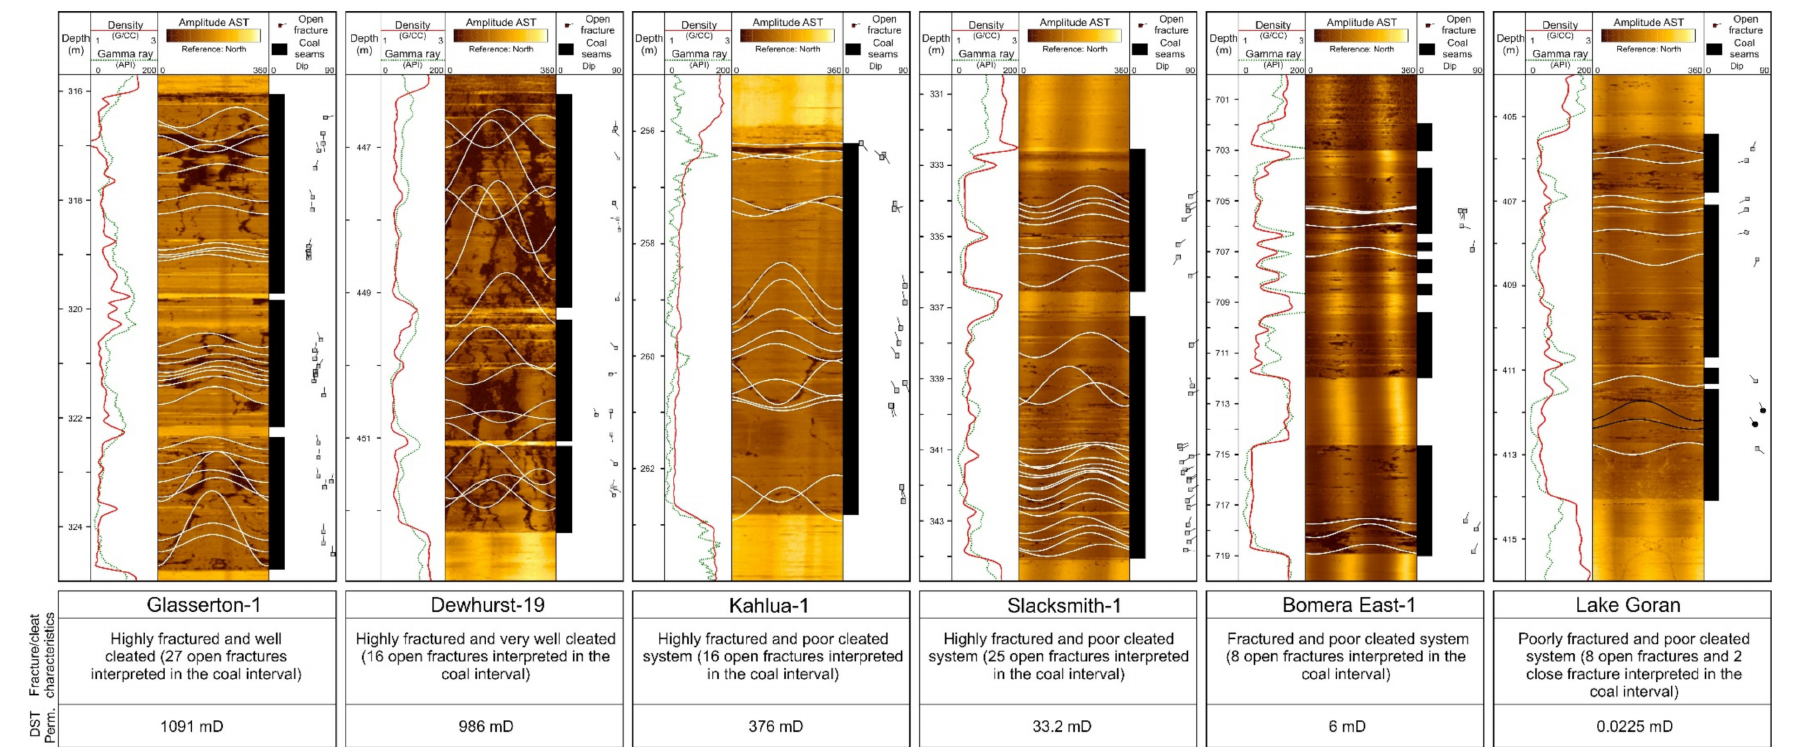
Figure 14. Cleat and fracture systems characterization by integrated borehole image log interpretation and DST data analysis for the Hoskissons Coals in six wells across the Gunnedah Basin [81] (This figure was originally published in The International Journal of Coal Geology Volume 165 Pages